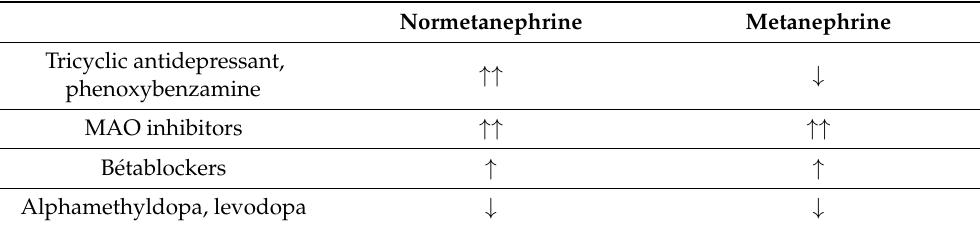
Table 2. Drug interactions with plasma metanephine and normetanephine. Normetanephrine Metanephrine Tricyclic antidepressant,